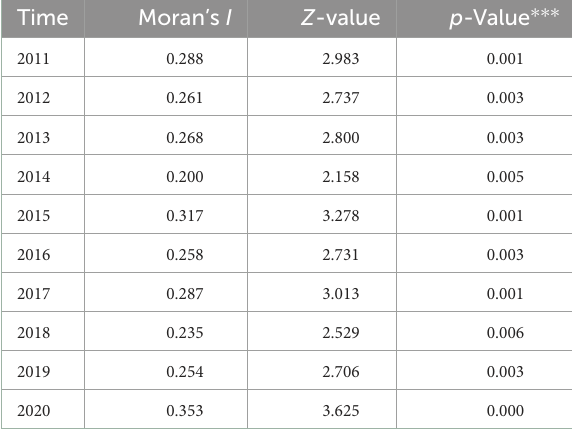
TABLE 4 Global Moran Index of economic resilience. Time Moran’s